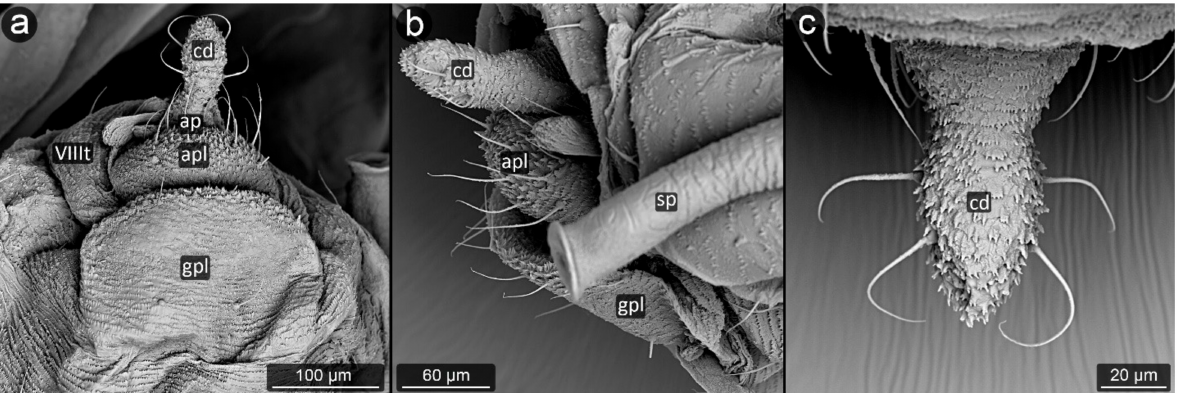
Figure 30. Perianal structure of Rhopalosiphum padi in SEM; ( a )—abdominal view, ( b )—lateral view, ( c )—close-up of